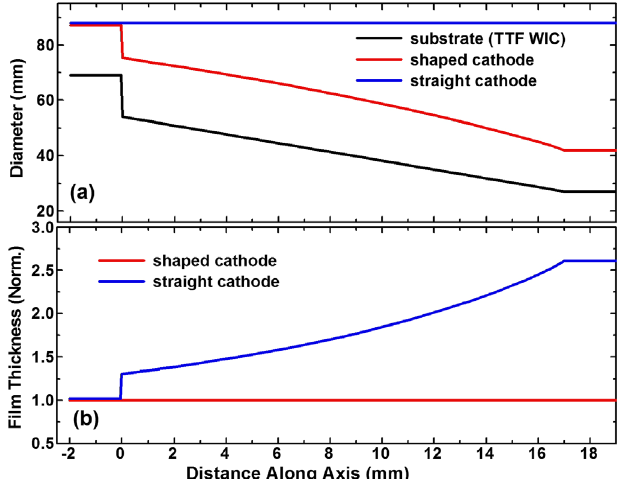
FIG. 6. (a) The diameter profiles of a straight cathode (blue), a shaped cathode (red) and the TTF WIC part (black). (b) Thickness variation (normalized) for a straight cathode (blue) vs a variable cathode (red).